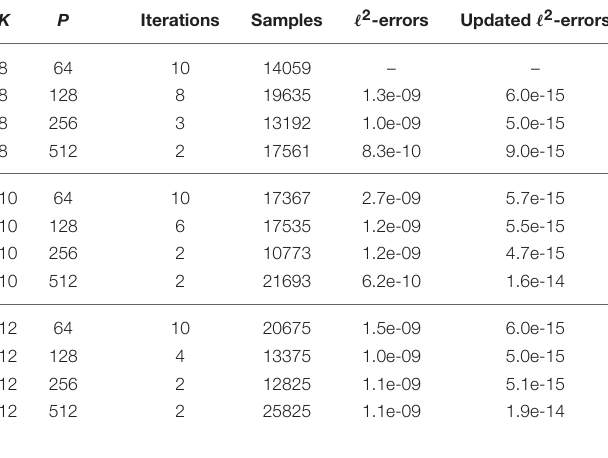
TABLE 6 | Results for Algorithm 3.2 via ESPRIT for frequency grid parameter S = 2 22 and sparsity M = 1024 with random coefficients on the unit